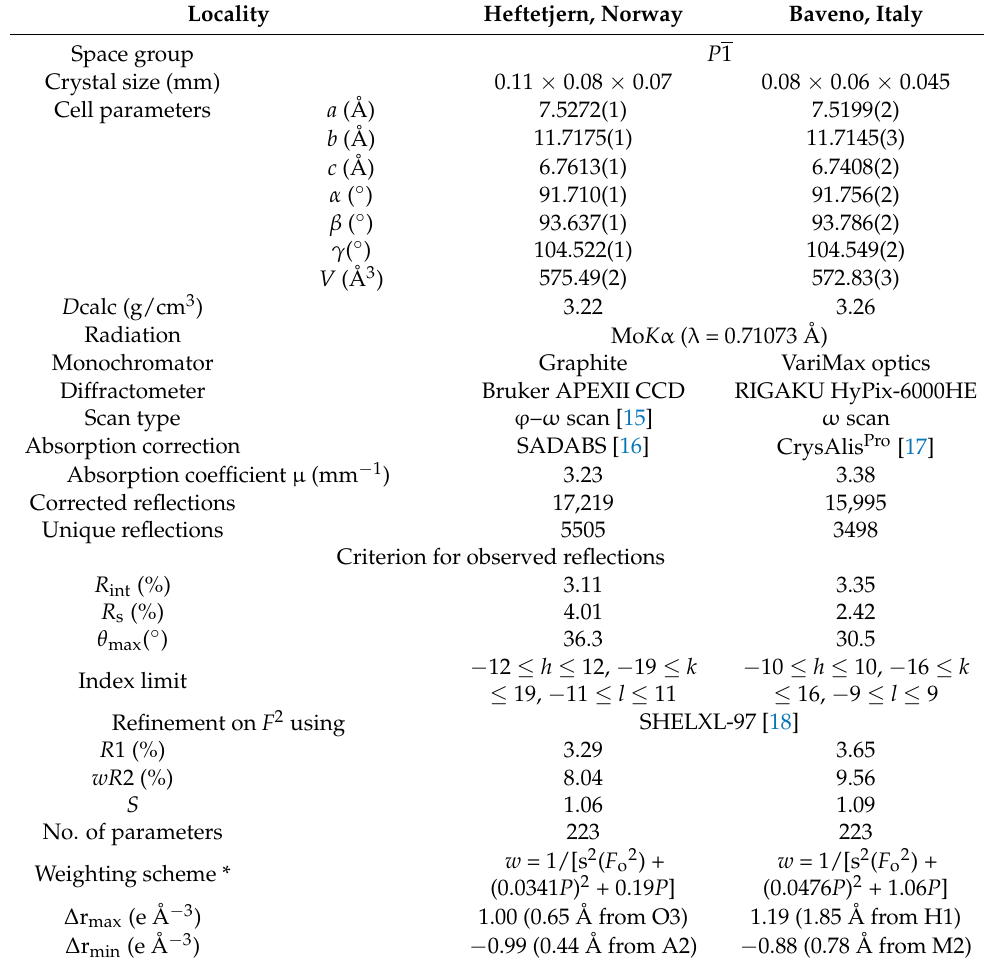
Table 2. Data collection and details of structure